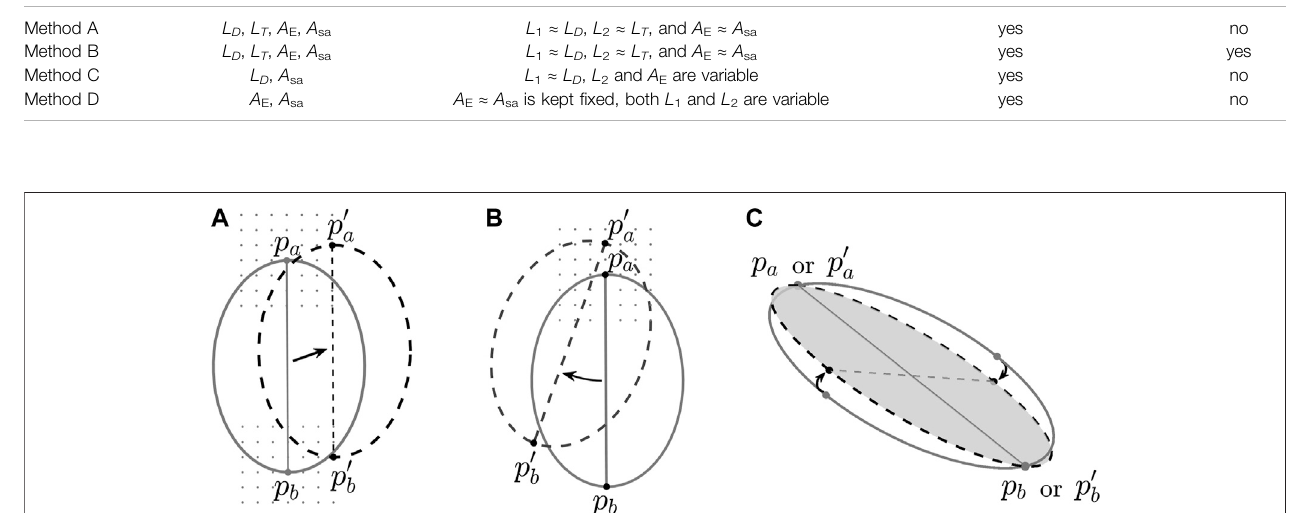
FIGURE 4 | The location/orientation of the reference ellipse: (A) translation, (B) translation and rotation, and (C) side-tilting (only in method B).